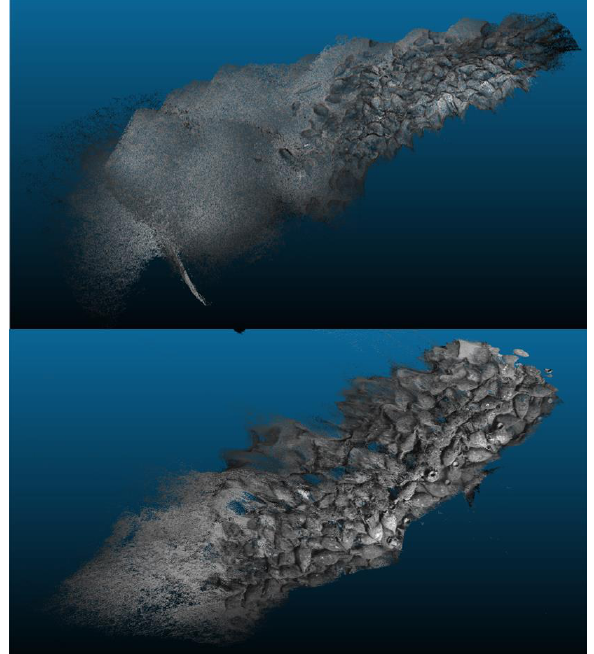
Figure 4. Dense models of B-3 (top) and B-4